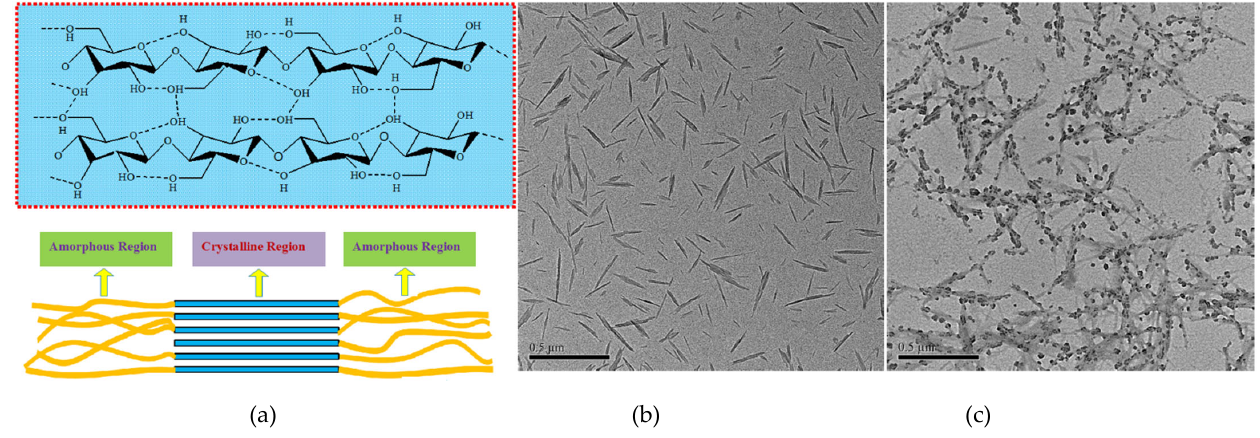
Figure 7. Molecular structure of nanocellulose macromolecule ( a ); TEM image of nanocellulose ( b ); nanocellulose–SO compound ( c ) [75,76].